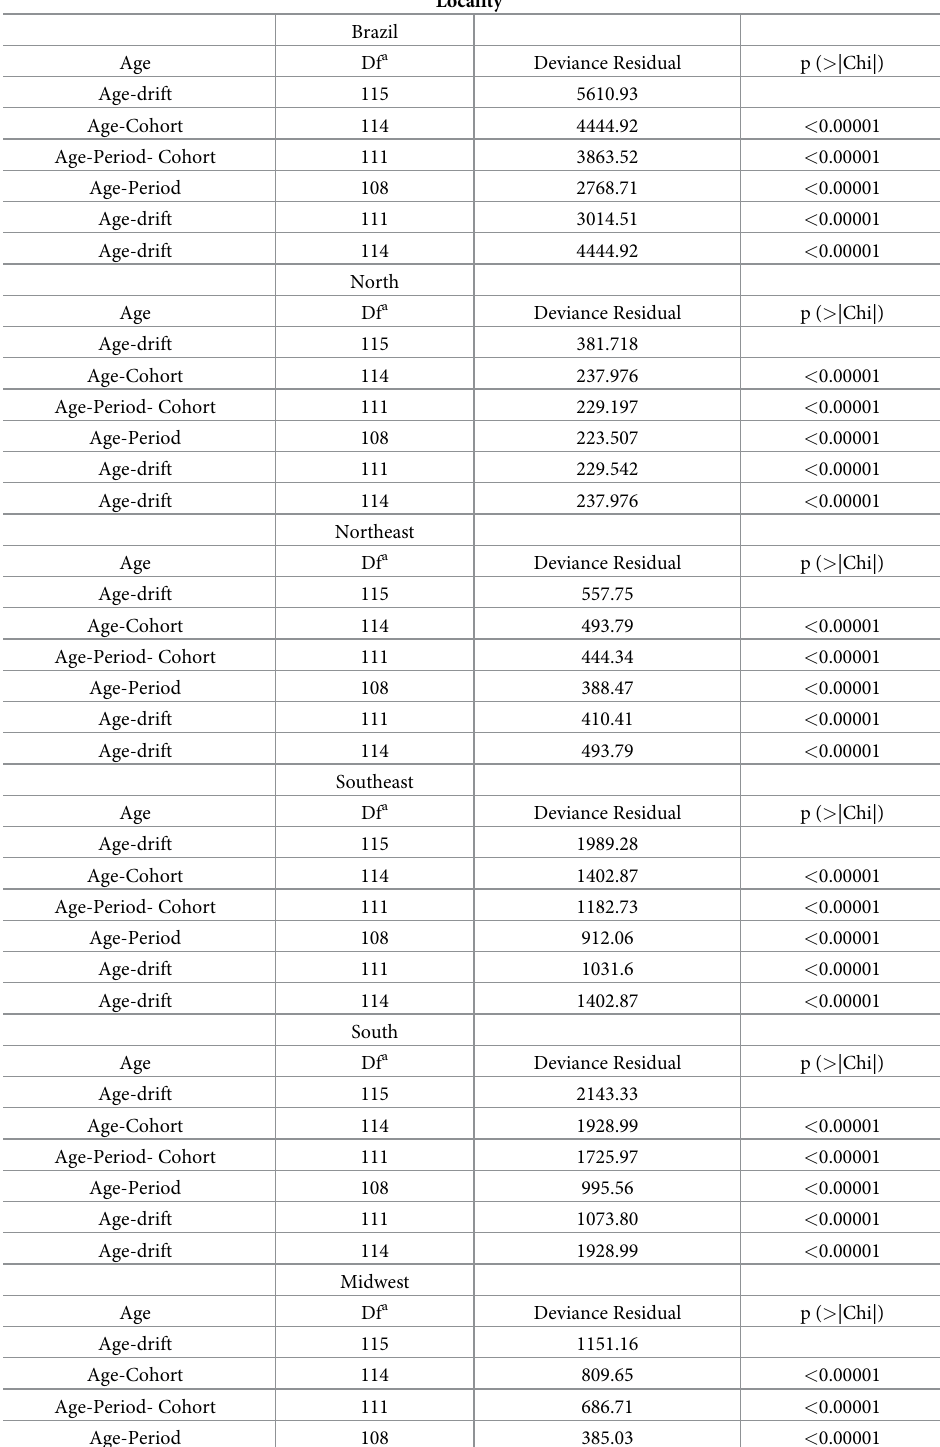
Table 4. Deviance an p-value analysis in sequential construction of age, period, and cohort models for suicides by firearms in men, according to Brazil its major regions, from 1980 to 2019.